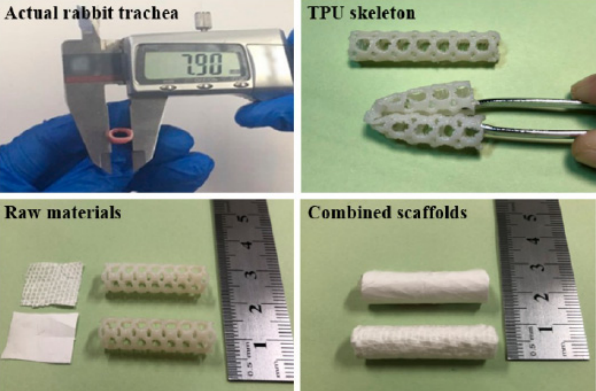
Fig. 7. Photograph of the actual trachea of rabbit and the raw materials of combined sca®olds.